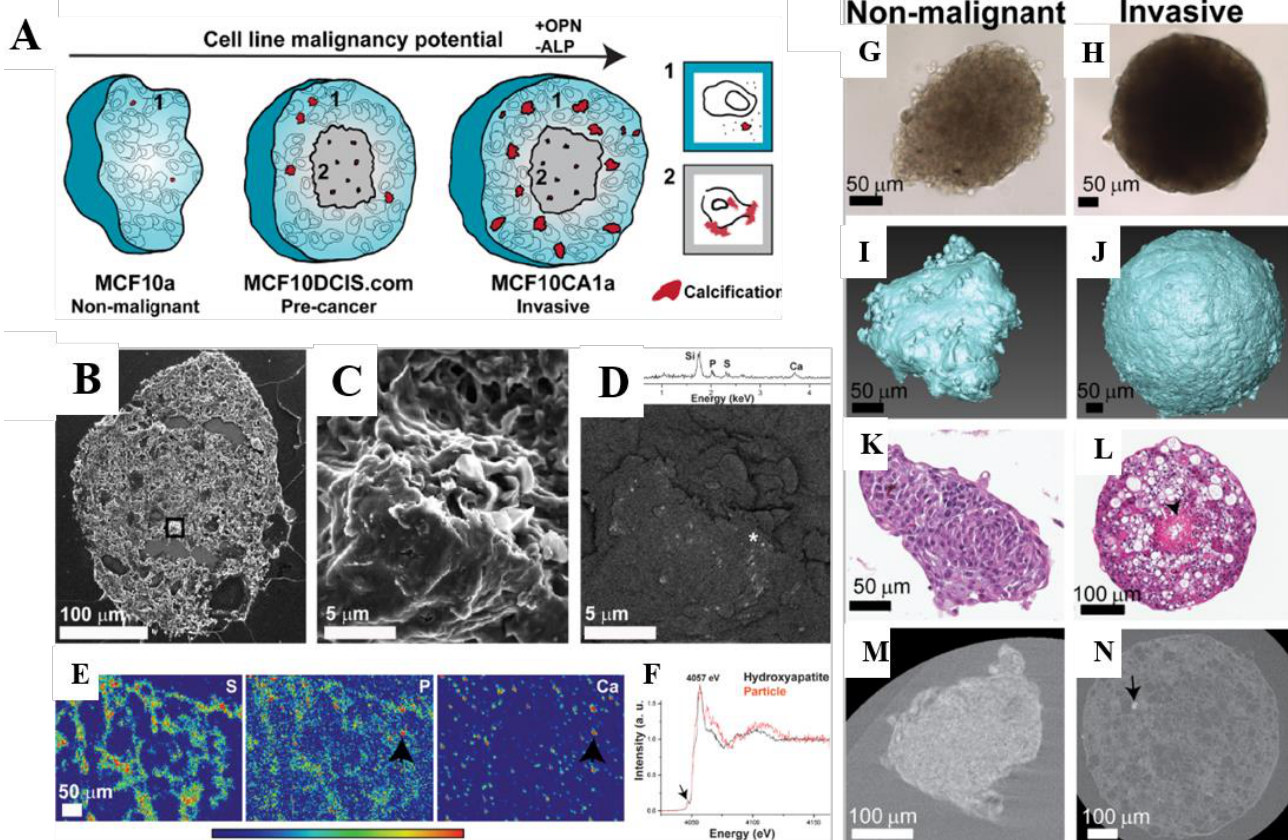
Figure 5. Panel of figures of in vitro 3D culture model of breast cancer microcalcifications from [98]. ( A ) A schematic description of the proposed mineralization pathways in the 3D in vitro breast cancer model of various tumor stages; while OPN expression levels increase, ALP expression levels decrease with an increase in malignancy potential of cell line. Viable cell region in light blue, necrotic core in gray, and calcification in red. ( B – D ) Mineralized particles in pre-cancerous MCF10DCIS.com spheroids core by SEM magnified section in images; EDS spectrum in image C of asterisk-marked area showing the presence of calcium (Ca), phosphorus (P), and sulfur (S). SRF maps of a spheroid section showing S, P, and Ca distribution in image ( E ). Ca K-edge XANES of the particle marked in E and a hydroxyapatite standard in image ( F ). ( G – N ) Characterization of non-malignant MCF10A ( G , I , K , and M ) and invasive MCF10CA1a ( H , J , L , and N ) spheroids at day 13 of culture; light microscope ( G , H ), 3D reconstructed volumes of spheroids ( I , J ), H&E histological staining ( K , L ), and nanoCT data stained with iodine of the spheroids cross section ( M , N ). All the figures of this panel are reproduced with permission from Studying biomineralization pathways in a 3D culture model of breast cancer microcalcifications by Vidavsky et al., 2018, Biomaterials, 179, 12 (doi:10.1016/j.biomaterials.2018.06.030). Copyright 2018 by Elsevier.